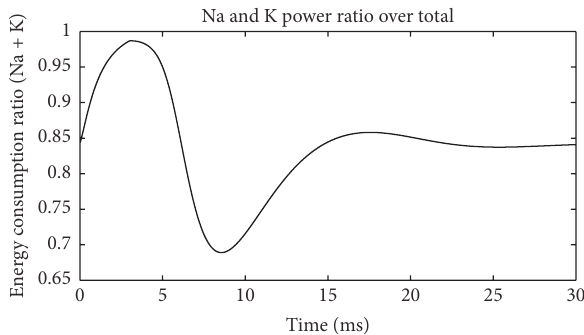
Figure 16: Sum of Na + and K + power over total power (suprathresh- old).